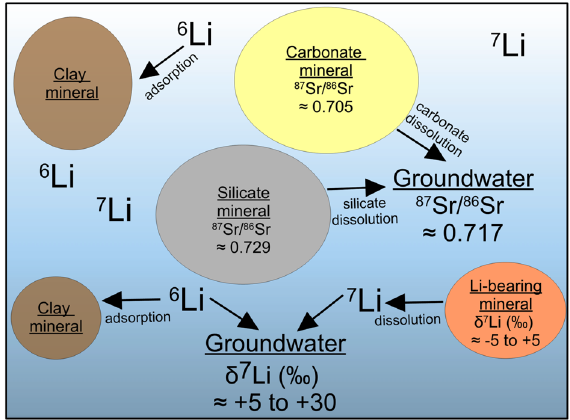
Fig. 3 Conceptual fi gure of an aquifer showing processes impacting on δ 7 Li and 87 Sr/ 86 Sr ratios in groundwater. The 7 Li is preferentially dissolved into groundwater from Li bearing minerals such as granite, with 6 Li preferentially adsorbed to mineral and clay surfaces, resulting in increasingly high δ 7 Li values in groundwater with processing. The 87 Sr/ 86 Sr ratios do not fractionate with dissolution, therefore ratios in groundwater are the result of the proportion of Sr from the dissolution of silicates and